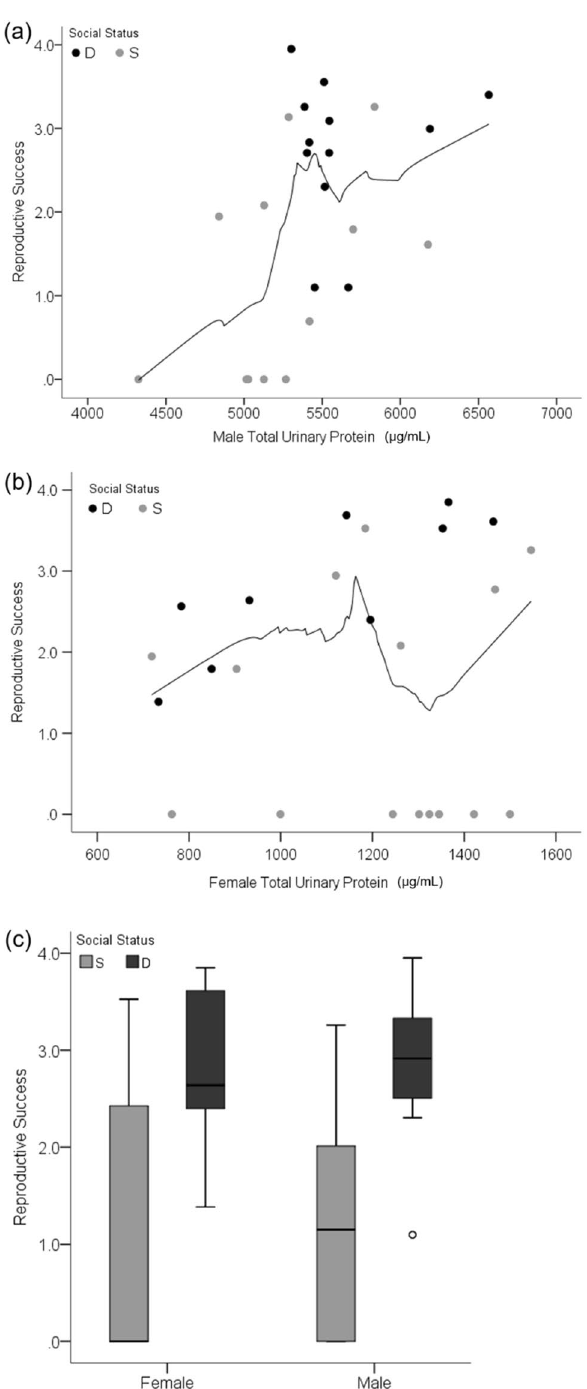
Figure 1. Reproductive success in relation to urinary protein and social status. Scatterplots show the total urinary protein concentration of males ( a ) and females ( b ) in relation to reproductive success. The boxplot ( c ) shows female and male social status in relation to reproductive success. Light gray coloration of data points and boxes indicate subordinate (S) social status during the enclosures. Black data points and dark gray boxes indicate dominant (D) social status. The black trend line in the scatterplots shows the loess (local regression) fit for non- parametric data (50% of data points to fit Epanechnikov